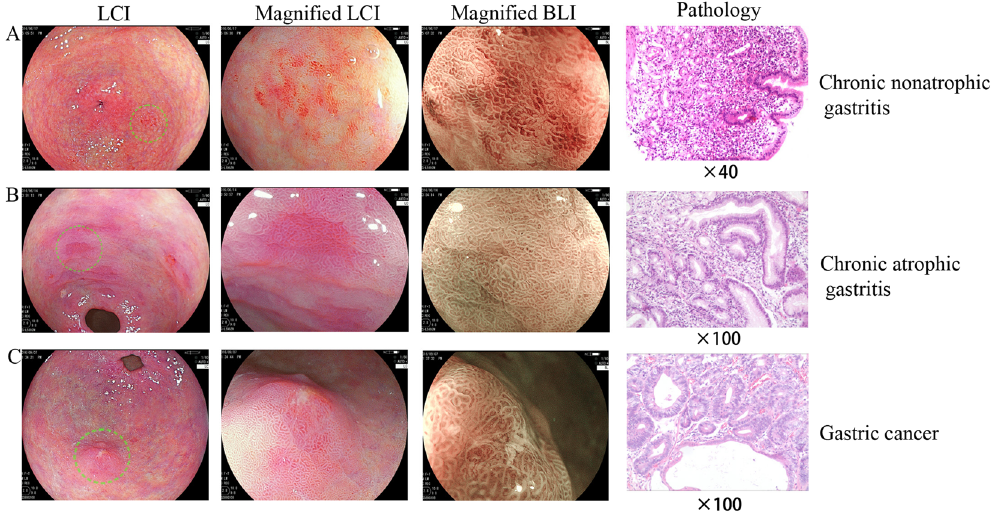
Figure 2. The CMV criteria were closely correlated with the pathological diagnosis. ( A ) chronic nonatrophic gastritis; ( B ) chronic atrophic gastritis; ( C ) gastric